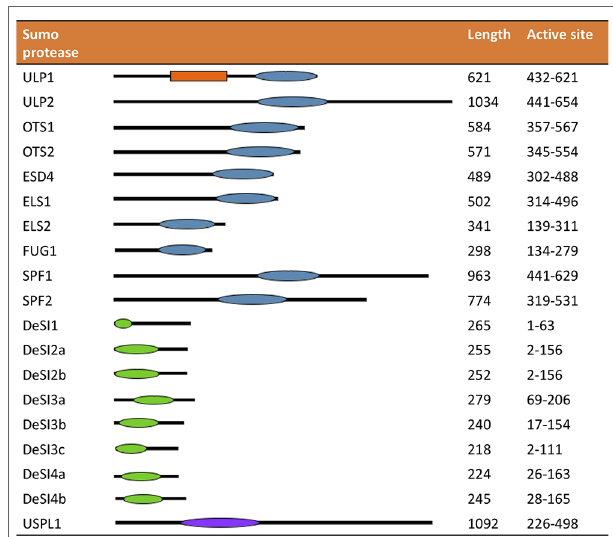
FIGURE 4 | The location of the active site and length of several different SUMO proteases. The orange box denotes the SIM site in ULP1. The blue oval depicts the location of the C48 active site, the green oval the C97 active site, and the purple oval the C98 active site.